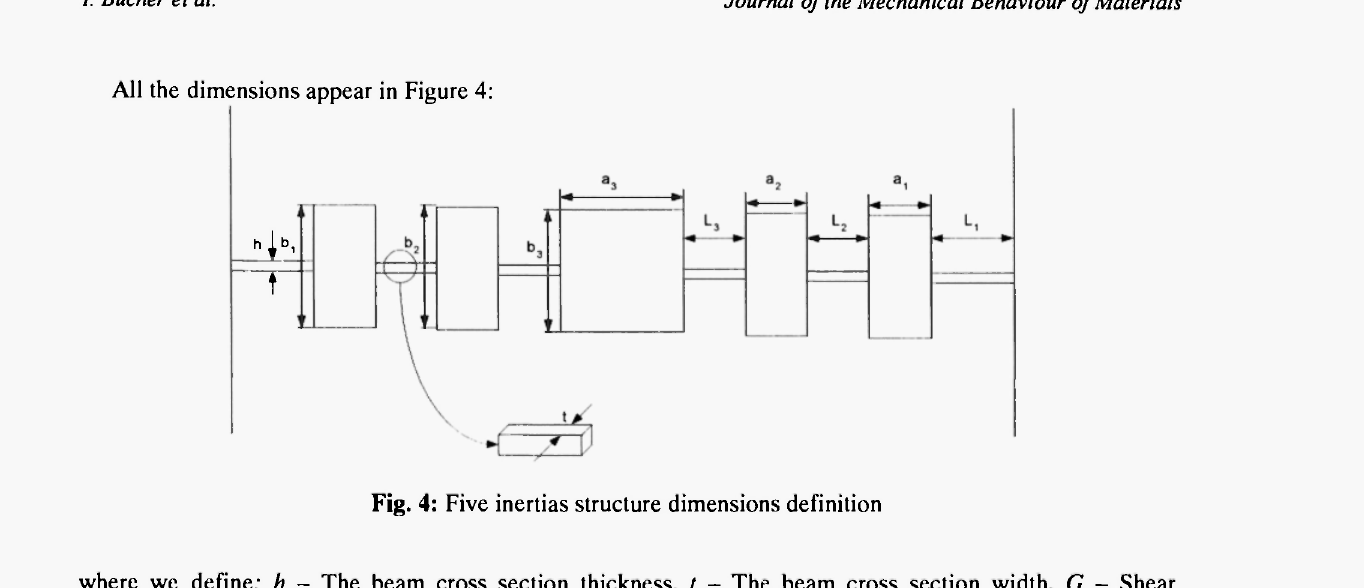
Fig. 4: Five inertias structure dimensions